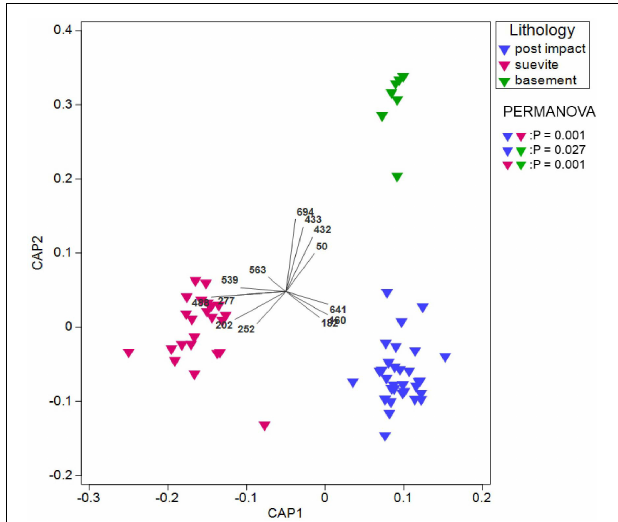
FIGURE 5 | Canonical analysis of principal coordinates (CAP) showing the spatial distribution of the microbial communities at the lowest taxonomic level in the three crater lithologies. Also shown are the probabilities for pairwise comparisons of the crater units. Vector overlay shows the dominant significant indicator species for each lithology. For details about the ISA, see Supplementary Tables 3 , 4